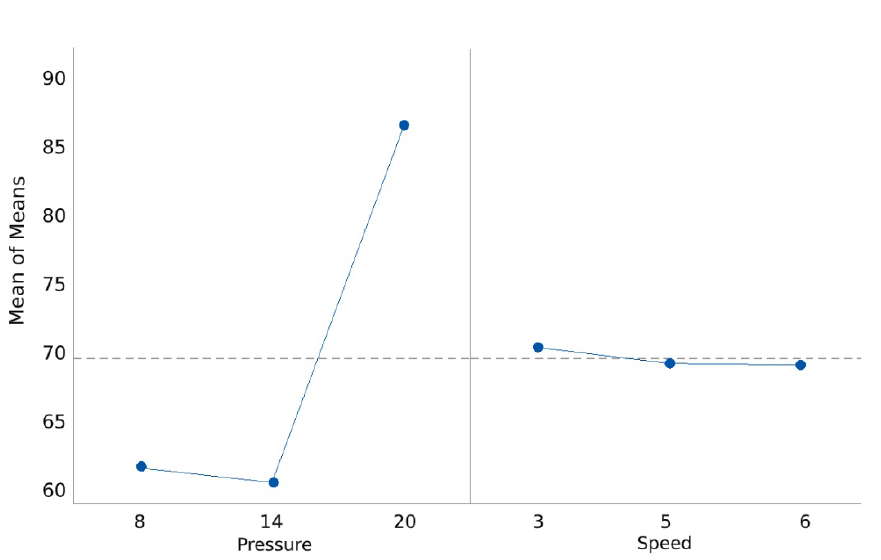
Figure 5. Main effect of the plot for mean values. Figure 5. Main e ff ect of the plot for mean